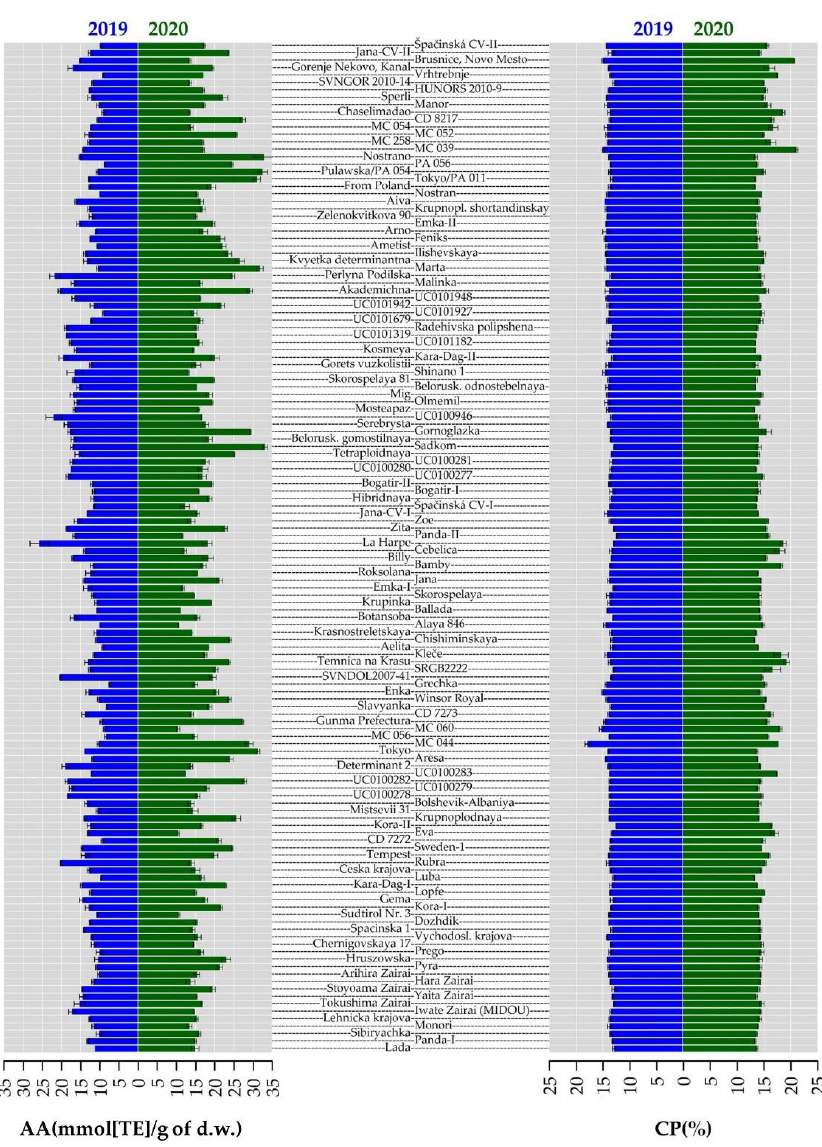
Figure 2. Antioxidant activity (AA) and crude protein content (CP) (AA) observed for the collection of 136 buckwheat genotypes. Blue and green bars represent the data from 2019 and 2020, respectively. The values are depicted as mean value from the respective year ± standard deviation.